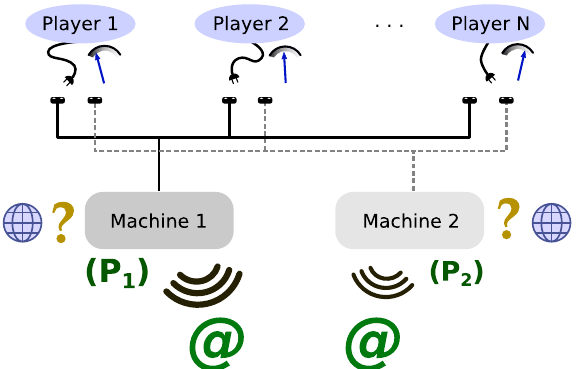
Figure 1. Principle of CMAB problem with N players and two machines, illustrated with internet connection. In every run, each player selects one machine to use to try to connect to the internet, which does so with a (unknown) probability P 1,2 . In case of connection, each player receives the same, shared bandwidth as the other players who selected the same